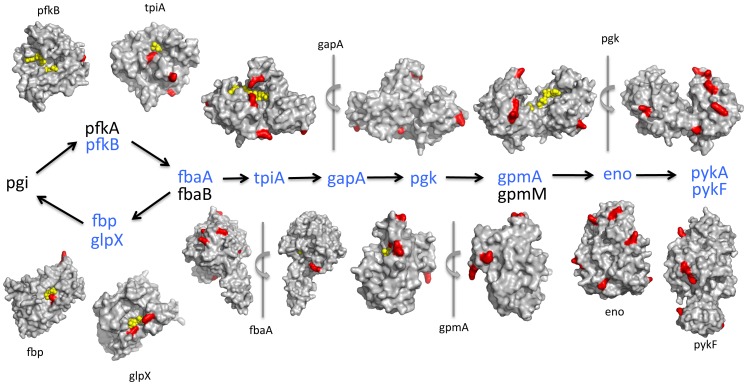
Surface representations of E. coli structures of glycolytic enzymes with acetylated lysines detected as upregulated in the ackA mutant relative to its WT parent.Proteins of the pathway that were detected as being upregulated by mass spectrometry are colored blue. The monomer of each protein, with the exception of pyruvate kinase A (PykA), is shown with a gray surface. Red patches on the structures represent upregulated acetyllysine residues. Front and back views of FbaA, GapA, Pgk, and GpmA are included and have an arrow denoting a 180° rotation of the structure. In most structures, a ligand in the active site of the protein is shown as yellow spheres.